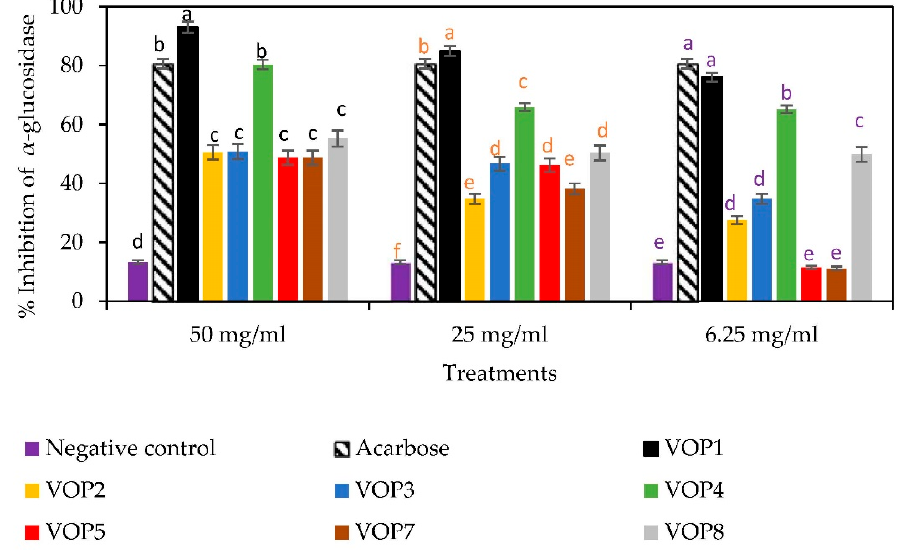
Figure 6. Percentage inhibition of leaf extracts of cowpea cultivars against α -glucosidase. Bars representing the enzyme activity for a specific leaf extract concentration with Bar with same alphabets are not significantly di ff erent between cultivars at p < 0.05. Data obtained were subjected to analysis of variance (ANOVA) using the statistical programme. Each bar represents the mean and standard deviation ( n = 3).